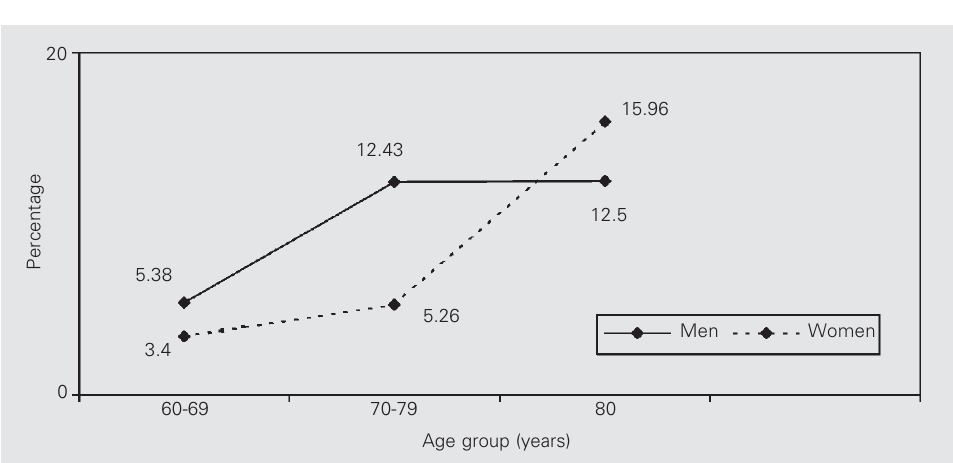
Figure 1. Prevalence of elevated serum creatinine levels by age and sex among the Bambuí Health and Ageing Study partici-